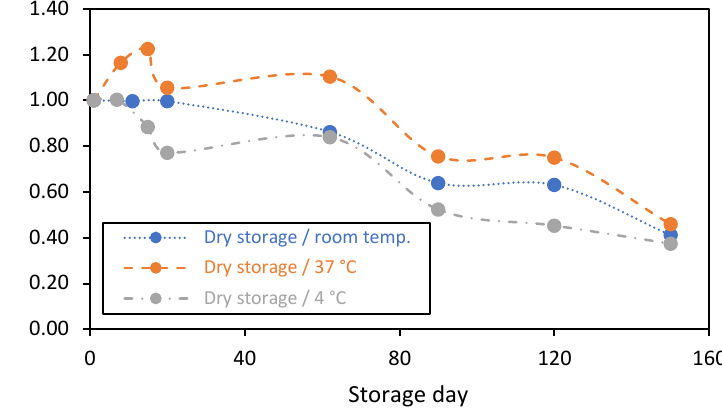
Figure 8. Stability in function of time of the chitosan-based biosensing membranes deposed on gold screen-printed electrodes and stored dry at various temperatures: (blue plot) room temperature, (orange plot) 37 °C, and (grey plot) 4 °C (n = 1 sensor).